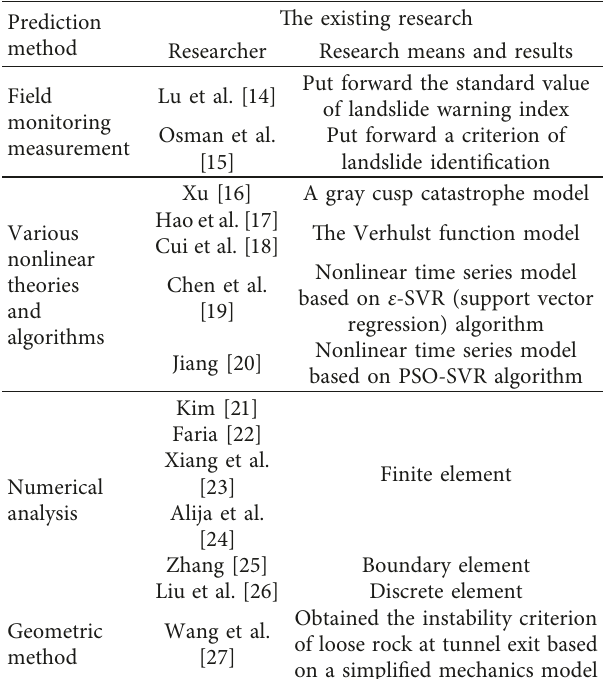
Table 1: Summary of prediction